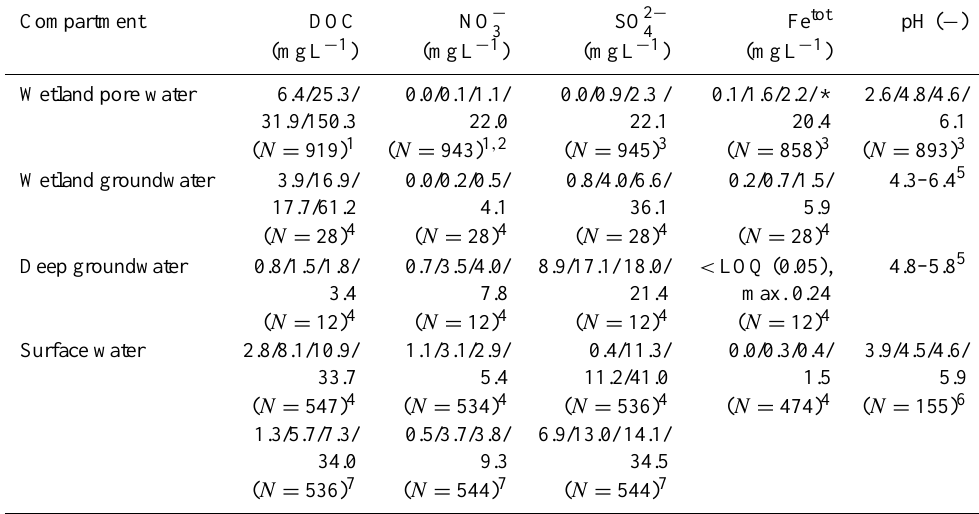
Table 1. Ranges in concentrations of DOC, nitrate, sulfate and total iron, and ranges in pH in the different analysed compartments “wetland pore water”, “wetland groundwater”, “deep groundwater” and “surface water”. Values represent observed minima/medians/means/observed maxima from the available dataset. Compartment DOC NO − 3 (mgL − 1 ) Wetland pore